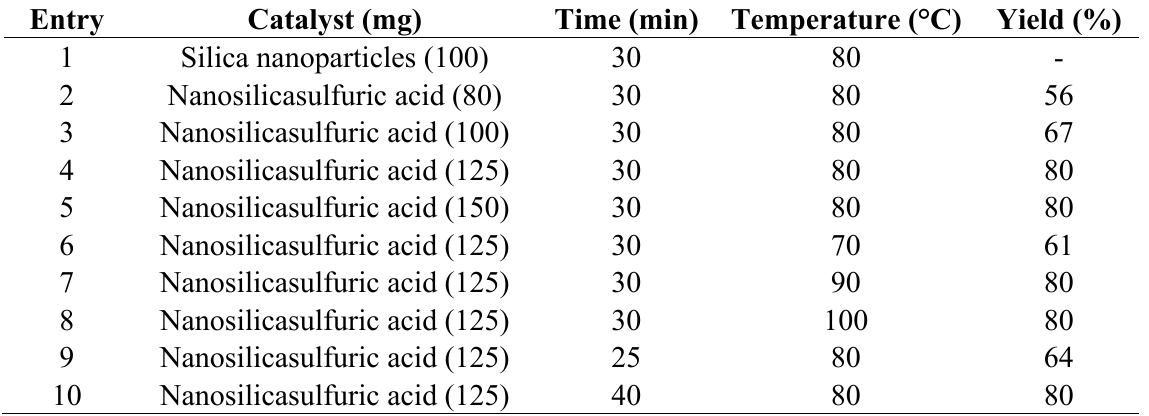
Table 1. Optimization of reactions under thermal conditions.